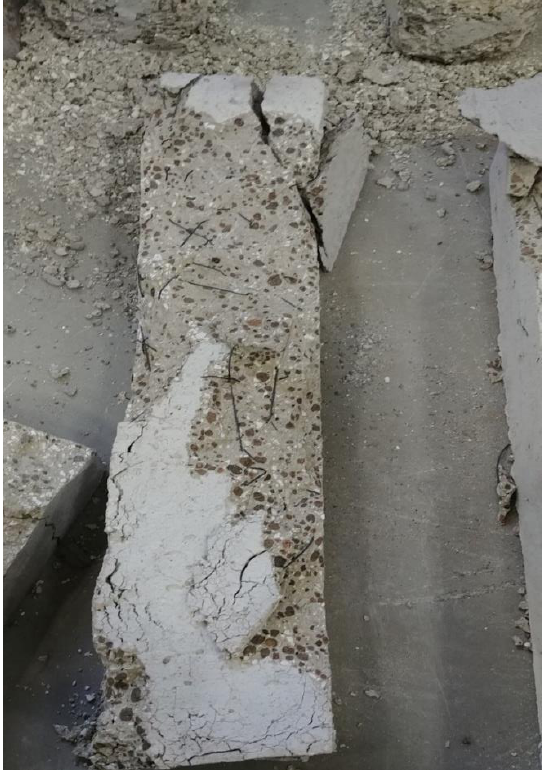
Figure 22. Spalled samples after temperature loading with 800 °C.